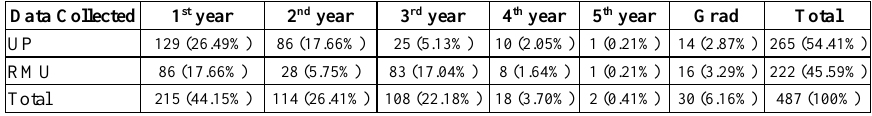
Table 4. Data collected classify by university and academic